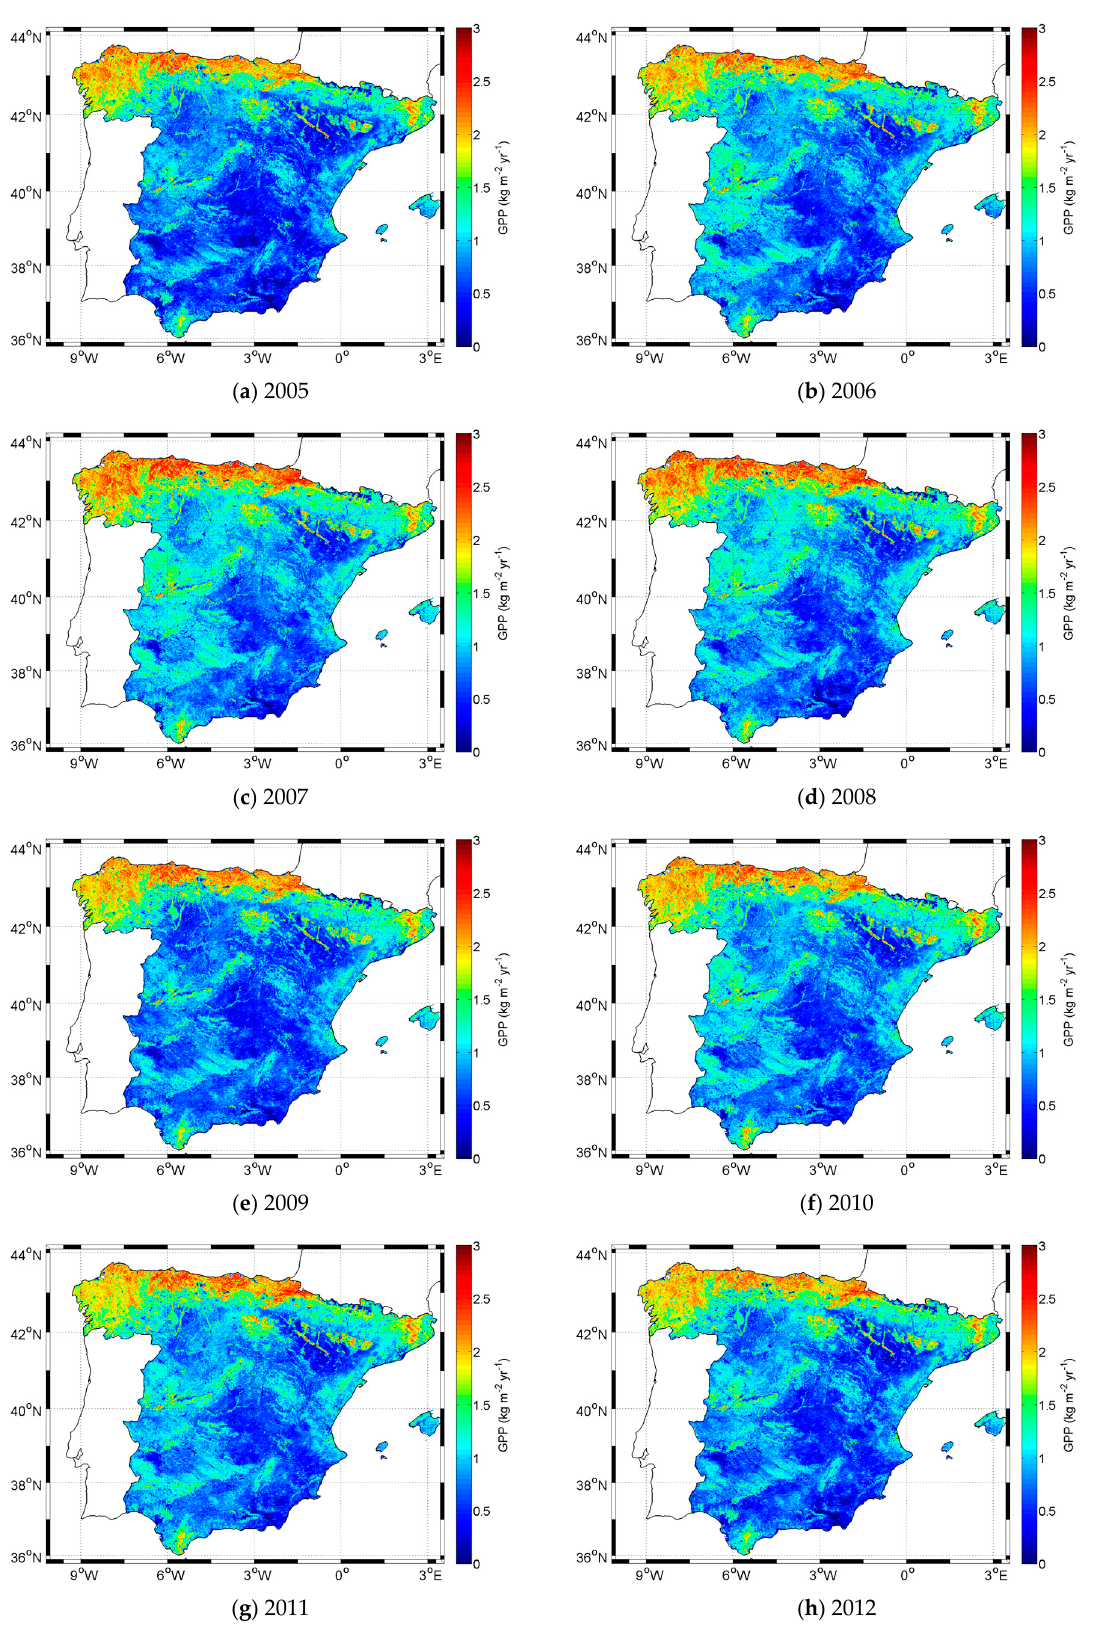
Figure 8. ( a – h )Images of (in kg·m − 2 ·yr − 1 ) for the 2005–2012 period obtained using the Figure 8. Images of GPP annual (in kg · m − 2 · yr − 1 ) for the 2005–2012 period obtained using the semi-empirical model with EVI and the coefficients in Table semi-empirical model with EVI and the coefficients in Table 4